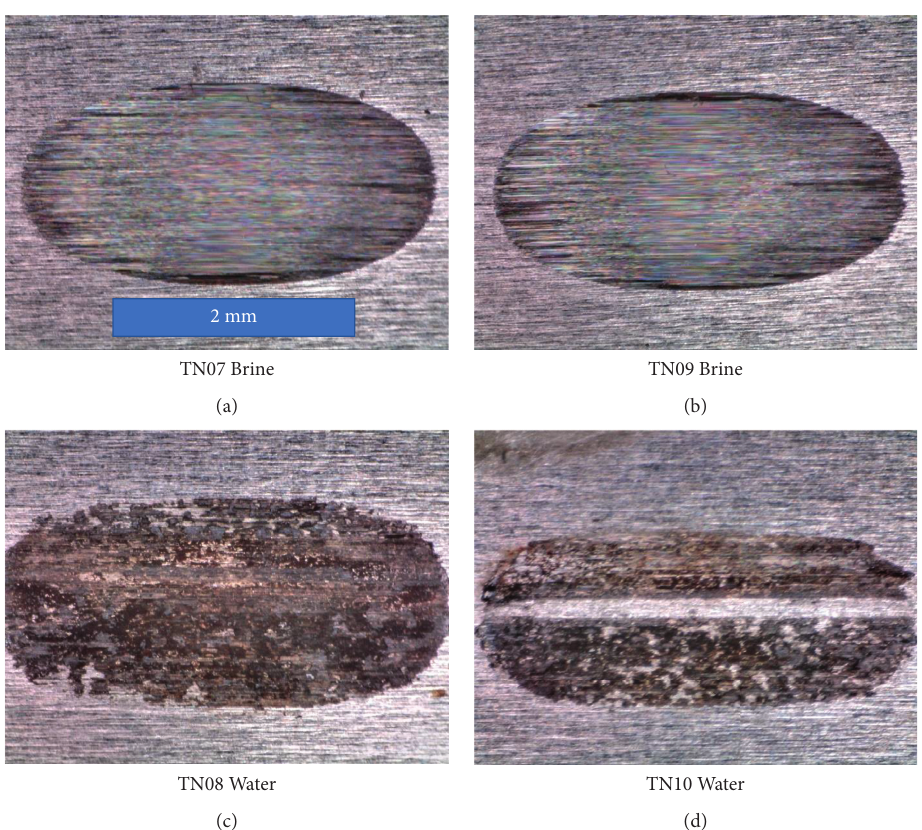
Figure 4: Friction data (scale shown in (a)). (a) TN07 brine. (b) TN09 brine. (c) TN08 water. (d) TN10